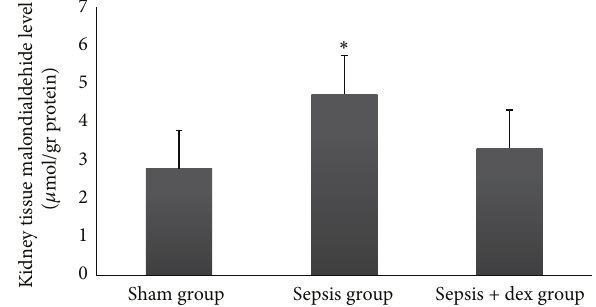
Figure 5: Alveolar macrophage counts in the experimental groups. ∗ 𝑃 < 0.05 compared with sham and sepsis + dex groups. & 𝑃 < 0.05 compared with sham